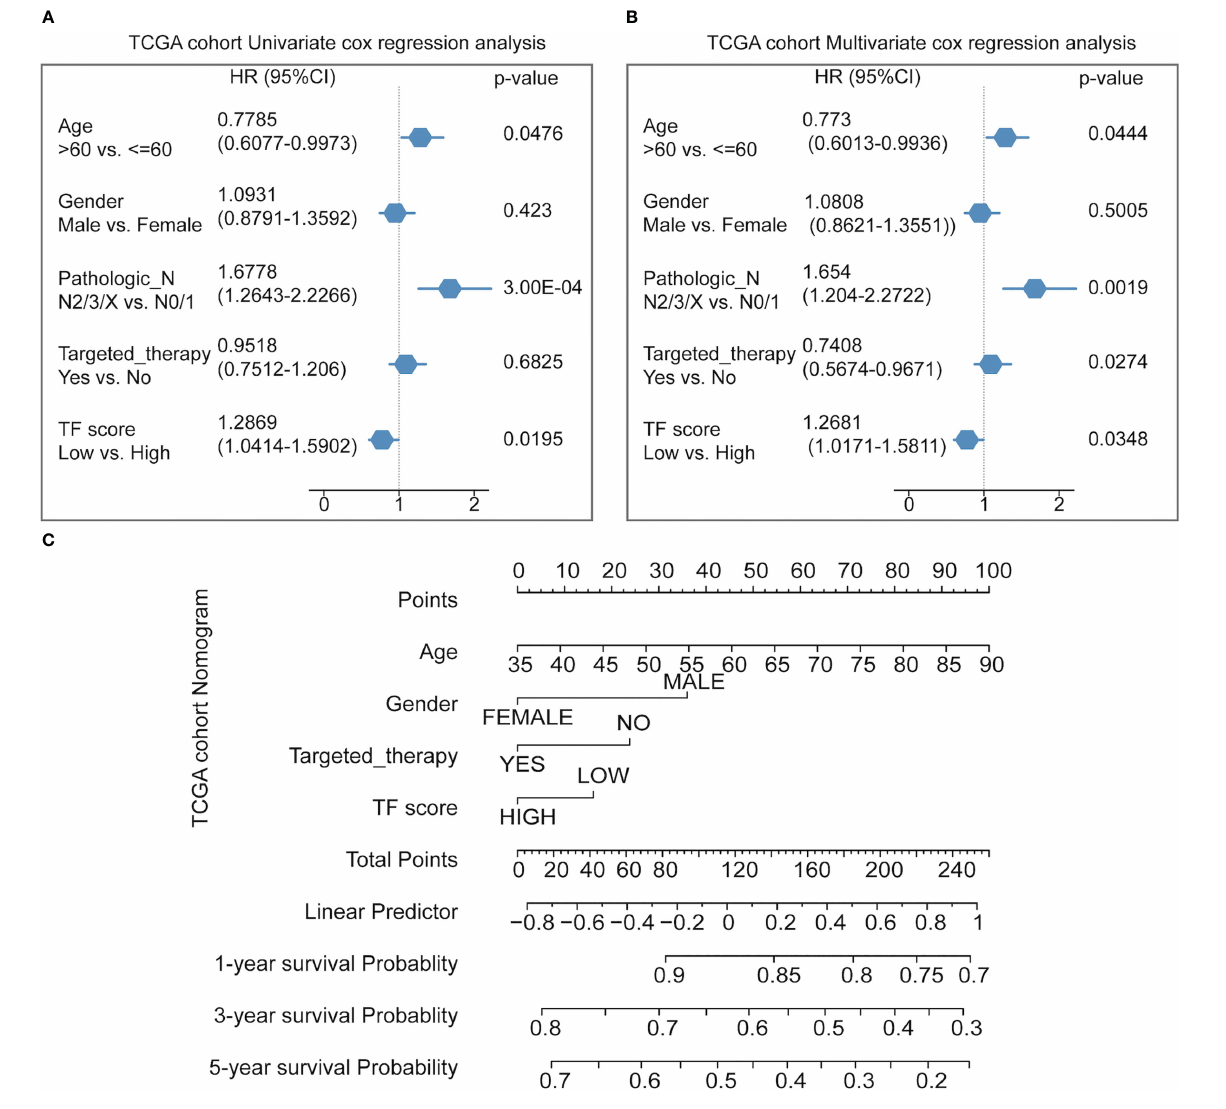
FIGURE 5 Predicting the prognosis probability in TCGA-NSCLC. (A) Univariate Cox regression analysis in the NSCLC cohort. (B) Multivariate Cox regression analysis in the NSCLC cohort. (C) Nomogram line graph for multivariate cox results of the NSCLC